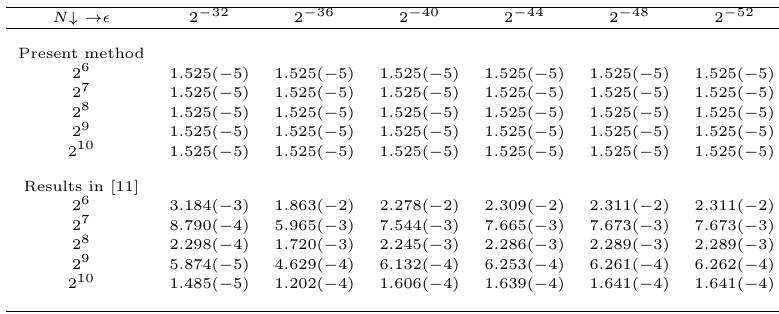
Table 2. Maximum absolute errors in the solution of Example